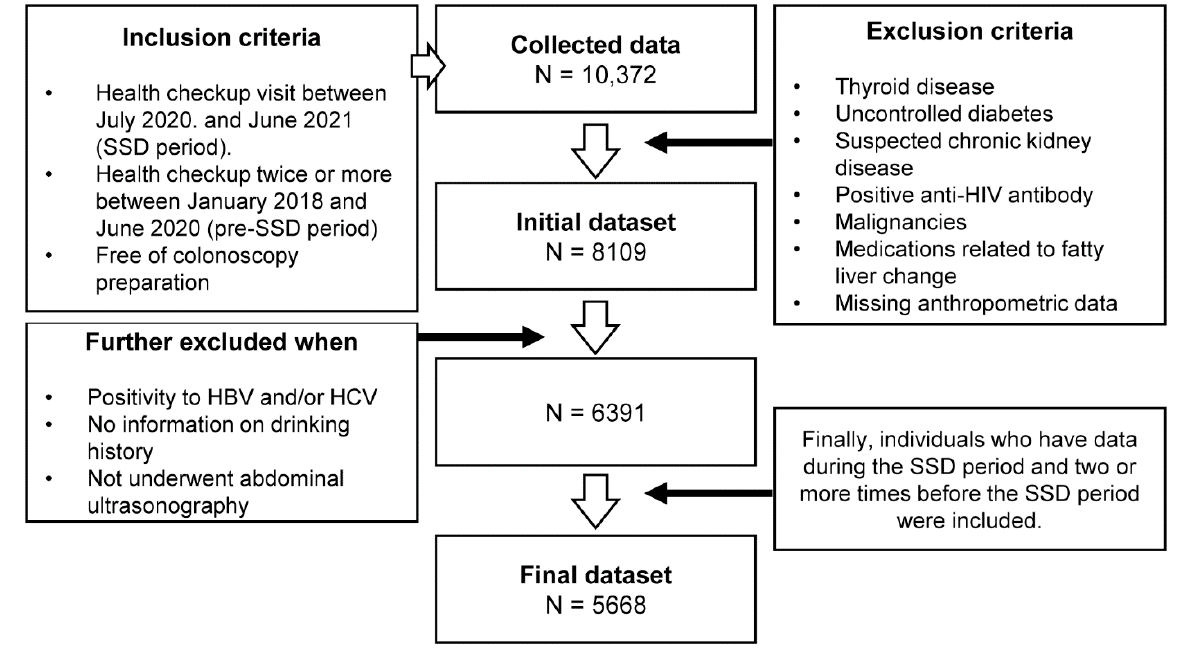
Figure 1. Flowchart of the study. SSD, systematic social distancing.